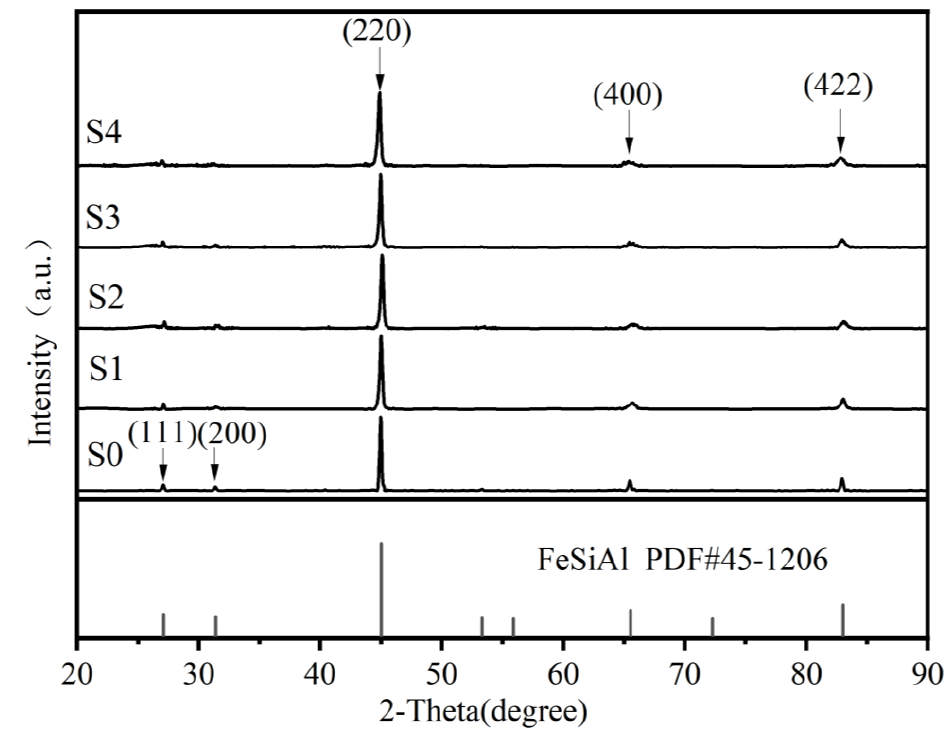
Figure 3. XRD patterns of the FeSiAl and FeSiAl@HC S0 − S4 samples.